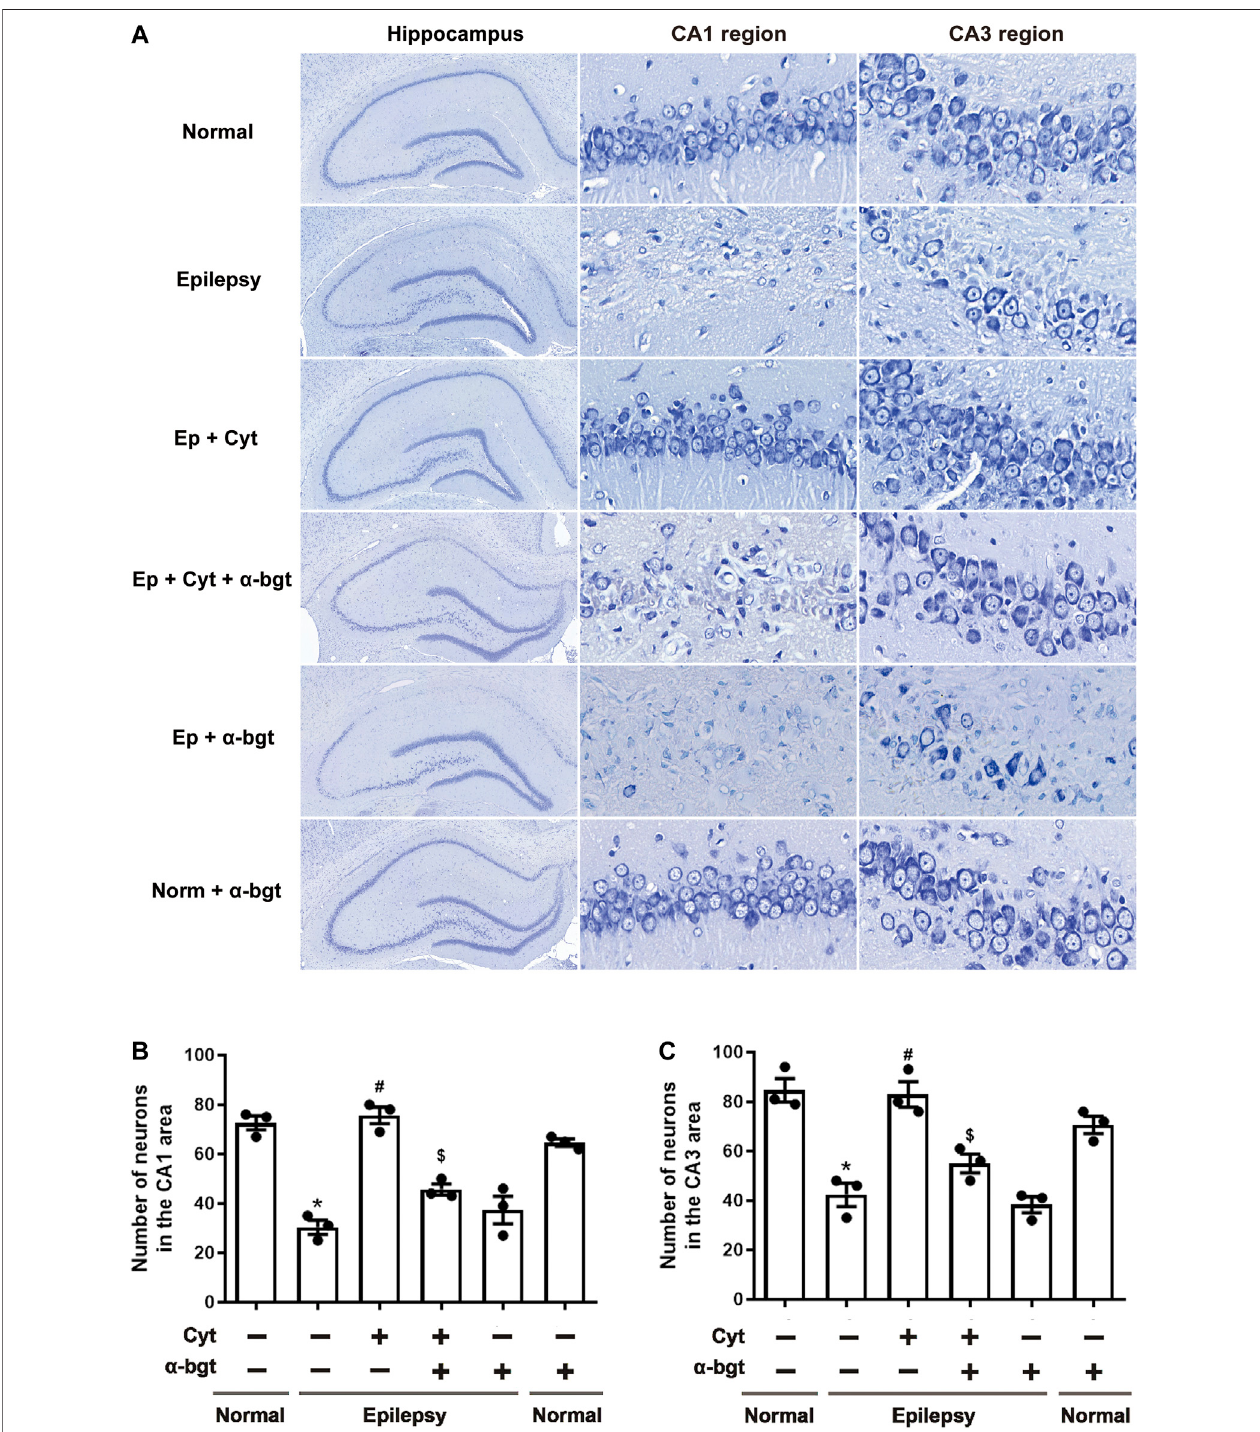
FIGURE2| Cytisineattenuateshippocampaldamageinepilepticrats. Nisslstainingwasusedtoassessneuronaldamageinhippocampalregions. A: Nisslstaining of the entire hippocampus (5 × ). CA1 and CA3 regions of the hippocampus (90 × ). B: Quantitative analysis of pyramidal neurons in CA1 regions. Statistical results are as follows: F (5,12) (cid:1) 33.59, p < 0.05, n (cid:1) 3; normal vs. epilepsy, * p < 0.05; epilepsy vs. epilepsy + Cyt, # p < 0.05; epilepsy + Cyt vs. epilepsy + Cyt + α -bgt, $ p < 0.05. C: Quantitative analysis of pyramidal neurons in CA3 regions. Statistical results are as follows: F (5,12) (cid:1) 22.618, p < 0.05, n (cid:1) 3; normal vs. epilepsy, * p < 0.05; epilepsy vs. epilepsy + Cyt, # p < 0.05; epilepsy + Cyt vs. epilepsy + Cyt + α -bgt, $ p < 0.05.